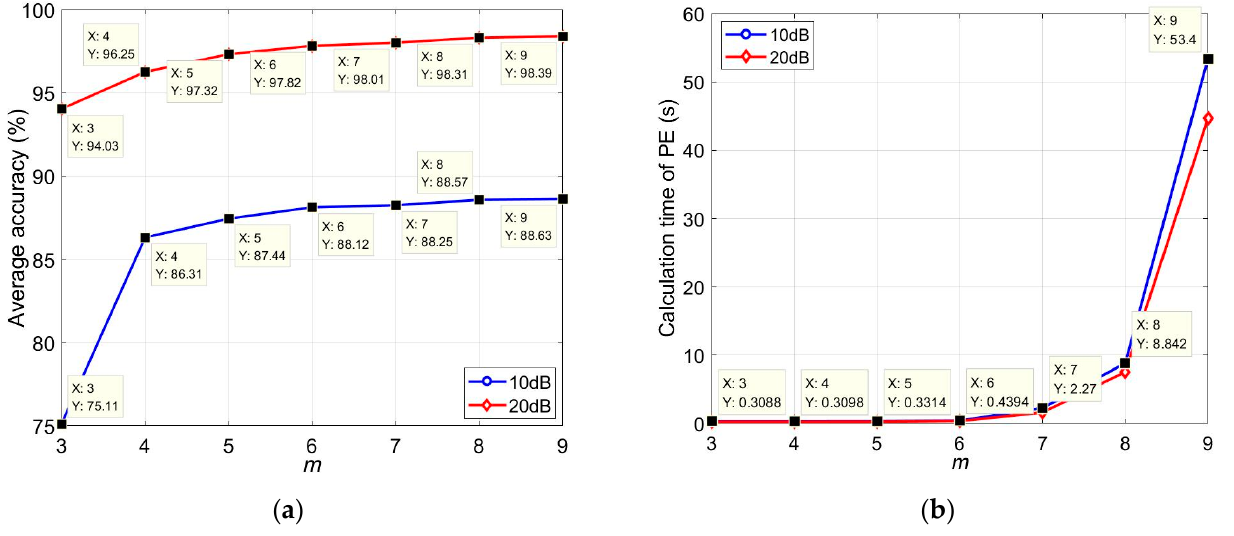
Figure 7. E ff ects of m on diagnostic results. ( a ) Accuracy; ( b ) Time-consuming. Figure 7. Effects of m on diagnostic results. ( a ) Accuracy; ( b )